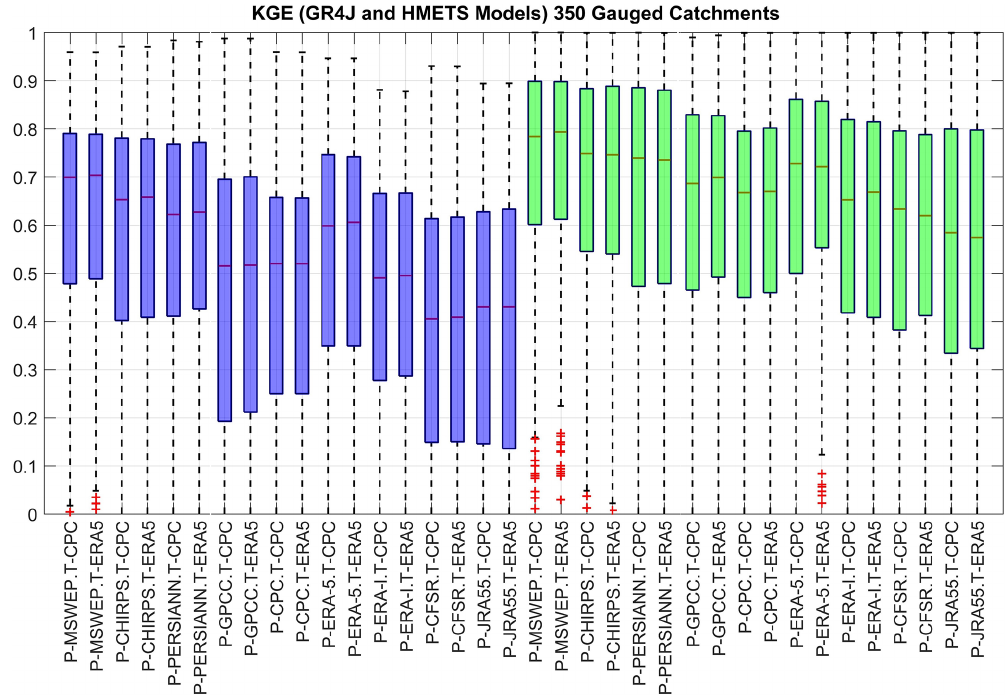
Figure 3. KGE calibration values using the 18 possible combinations of precipitation and temperature datasets, for both hydrological models (GR4J in blue and HMETS in green) for each of the 350 selected gauged catchments. Table 3. Mean percentage of variance for six streamflow metrics for 1145 catchments. All main effects (P, GCM, temperature ( T ) and HM) and first-order interactions are shown in rows 3 to 12. The last row sums up the second- and third-order elements’ contribution to variance. QQ5 and QQ95 are, respectively, the 5th and 95th quantiles of streamflow distribution. QX1 is the 30-year mean of the annual daily maximum streamflow value. The rows in bold outline the main contributors to variance. Mean relative variance (%) Mean